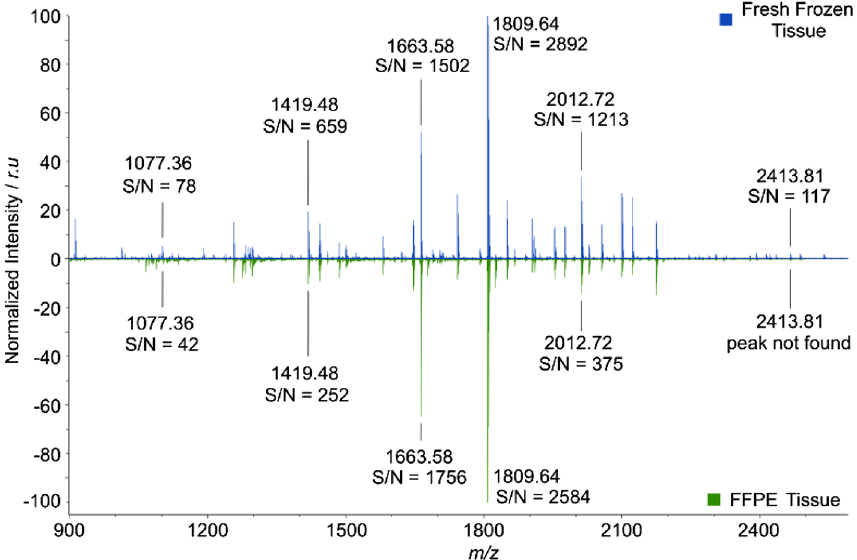
Figure 3. Comparison of normalized average mass spectra acquired from fresh frozen CCA tissue sections (top, blue) and FFPE tissue TMA of PDAC/CCA (bottom, green). Six detected m/z -values matching potential N-glycans are annotated with corresponding signal-to-noise ratio (S/N) values for fresh frozen and FFPE measurement. Peak at m/z 2413.81 was not detected in FFPE